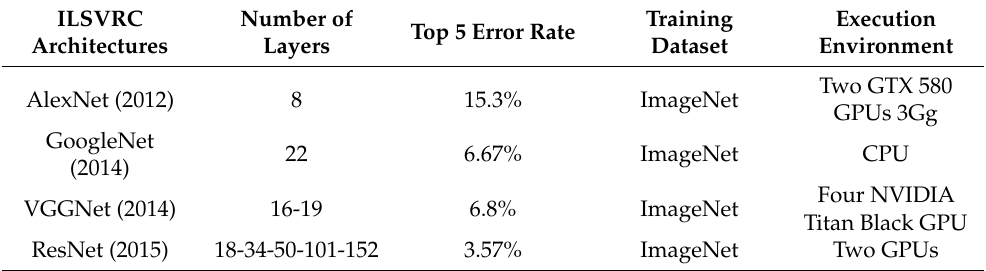
Table 1. Comparison between different CNN architectures for image